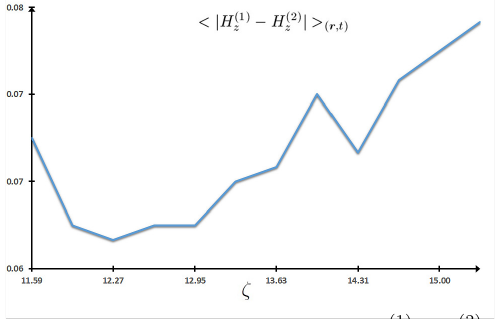
Figure 3. ζ -dependency of the average < | H (1) z − H (2) z | > ( r,t